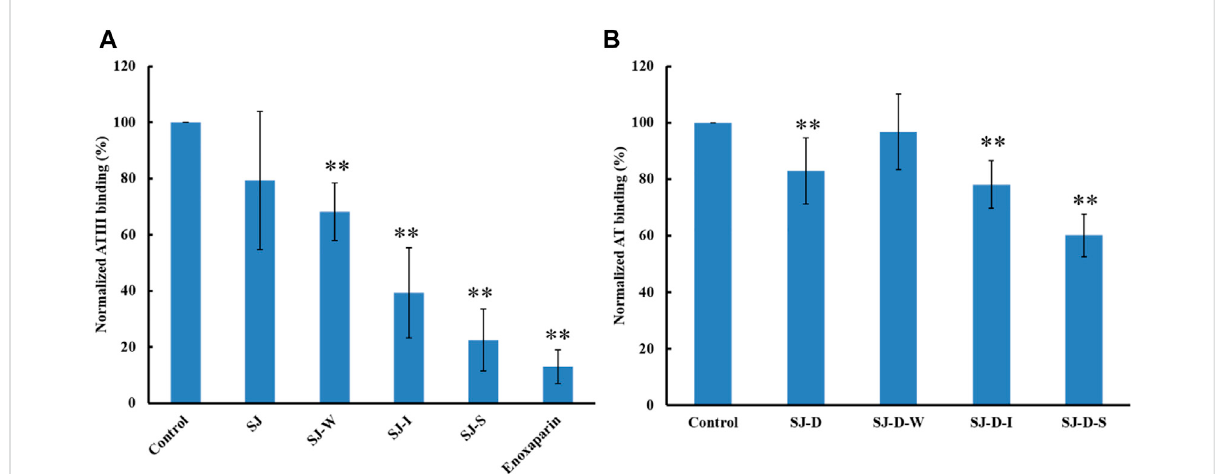
FIGURE 3 The binding abilities to AT (250 nM) premixed with different MW of polysaccharides (1 µM) on a heparin chip. (A) SJ and its fractions; (B) low molecularweightSJ-Danditsfractions.Allbargraphswithstandarddeviationswerebasedontriplicateexperiments.* p < 0.05,** p < 0.01compared with